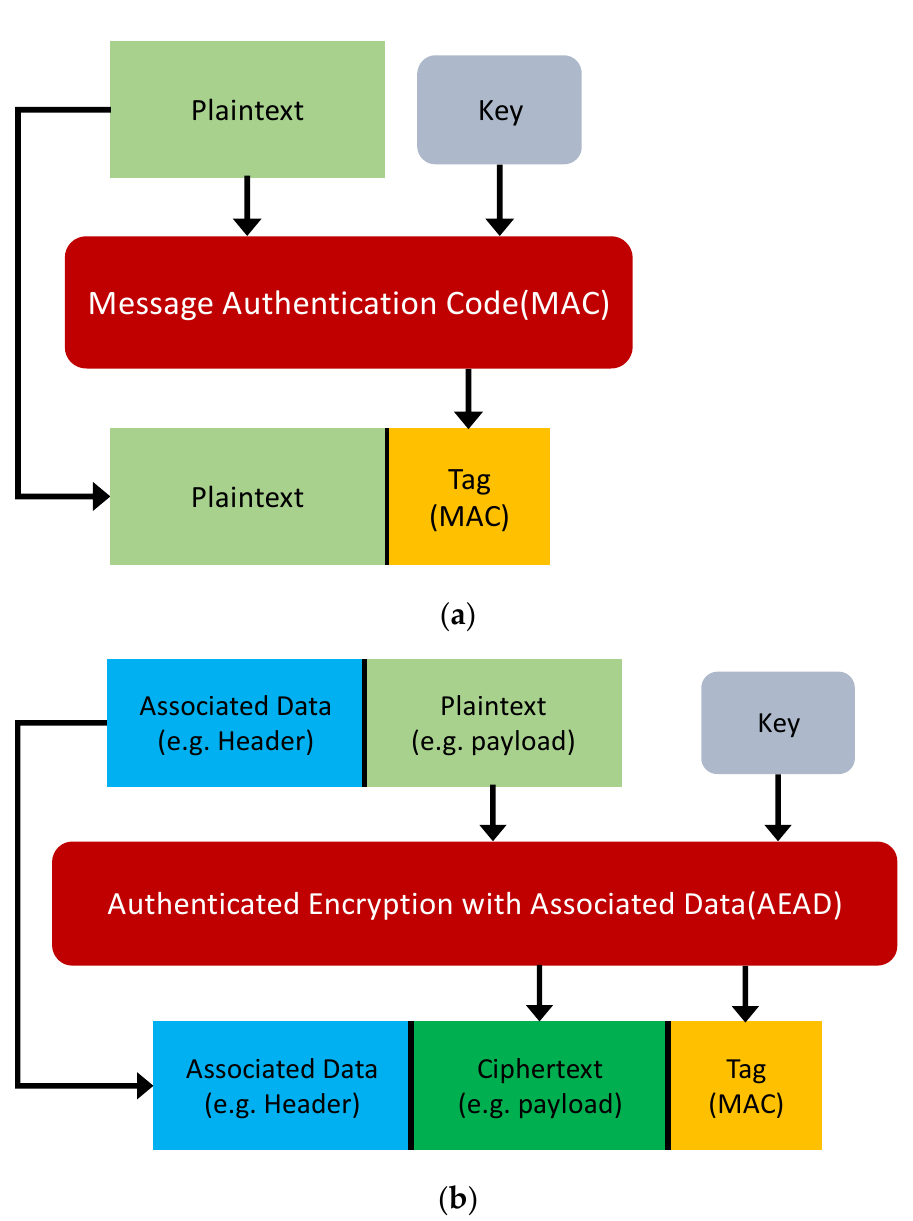
Figure 5. Working principle of the MAC and AEAD algorithms: ( a ) MAC; ( b ) AEAD. In the formula, M is the input message, f MAC is the MAC function, K is the shared symmetric key, and MAC is the message authentication